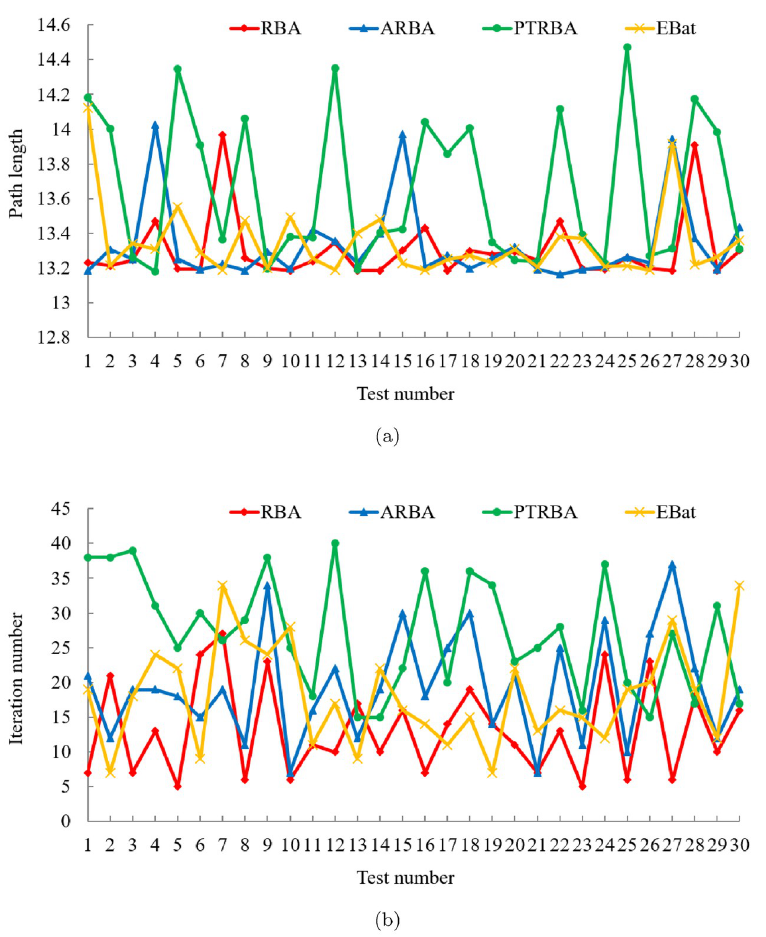
Fig 4. Experimental results of four algorithms in test case 1. (a) Path length. (b) Iteration number.